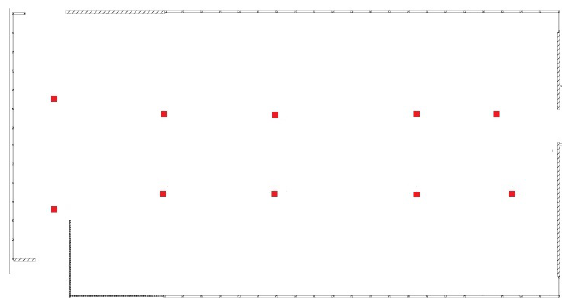
Figure 4. Ten selected locations we used in our case study in Section